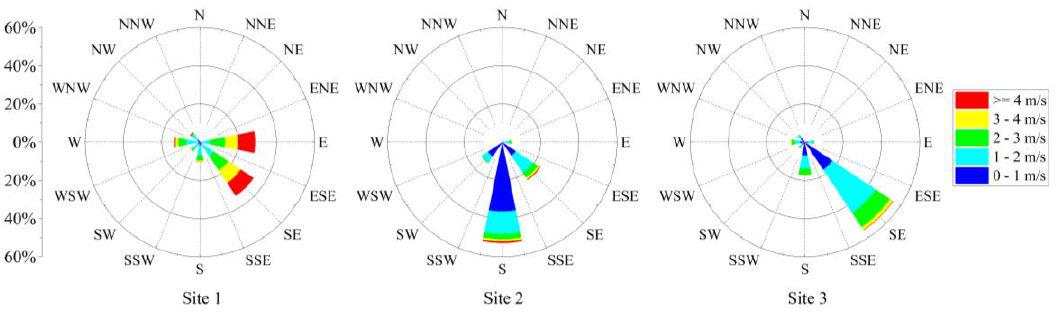
Figure 2. Wind rose for the three measurement sites over a three-month period.